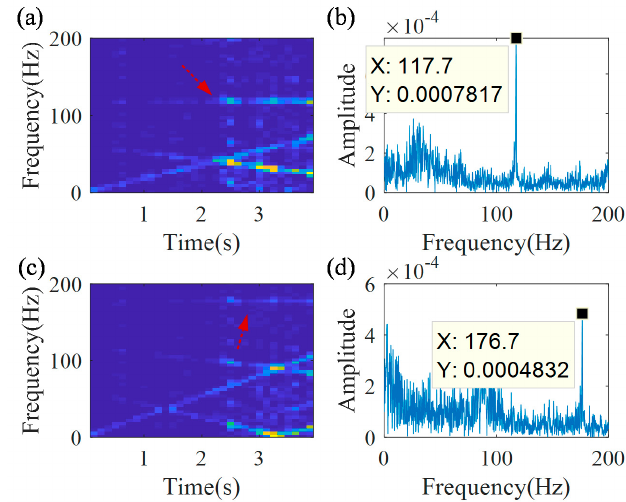
Figure 21. IFCF harmonic-related demodulation results; ( a ) 2nd harmonic-related TFR; ( b ) 2nd harmonic-related spectrum; ( c ) 3rd harmonic-related TFR; and ( d ) 3rd harmonic-related spectrum.